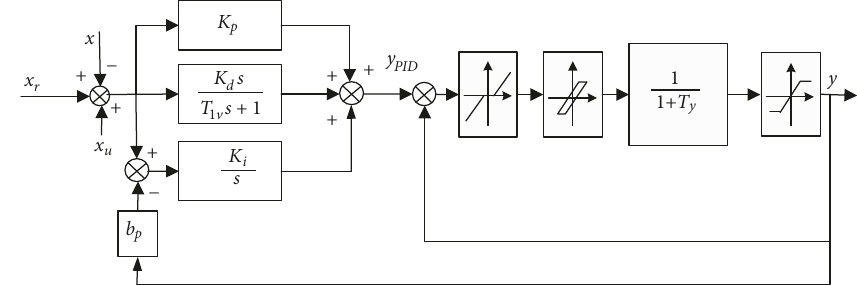
Figure 1: PID control device and electric-hydraulic servo system.